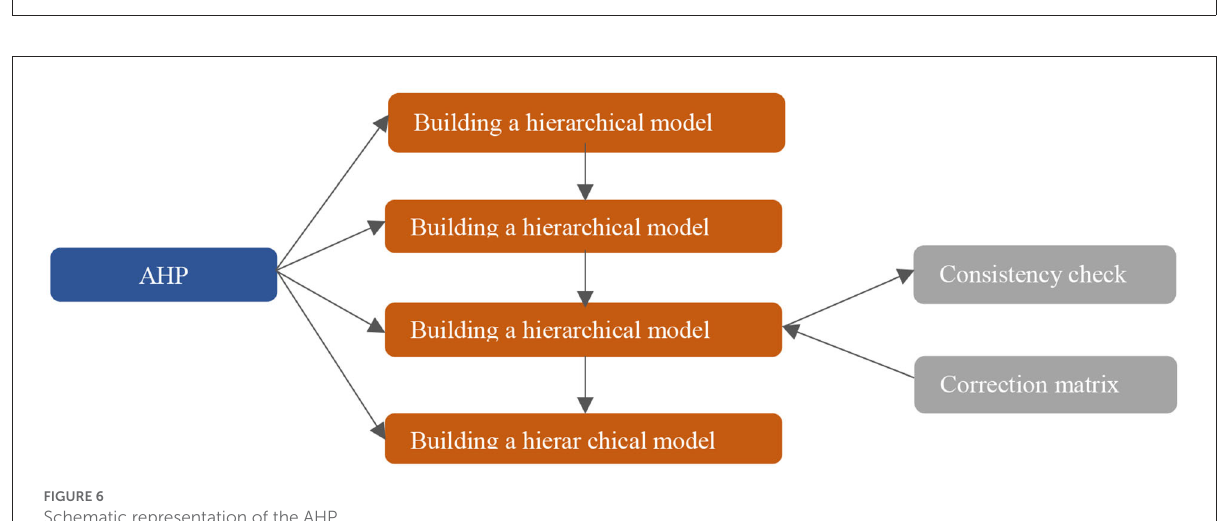
FIGURE6 Schematic representation of the AHP.